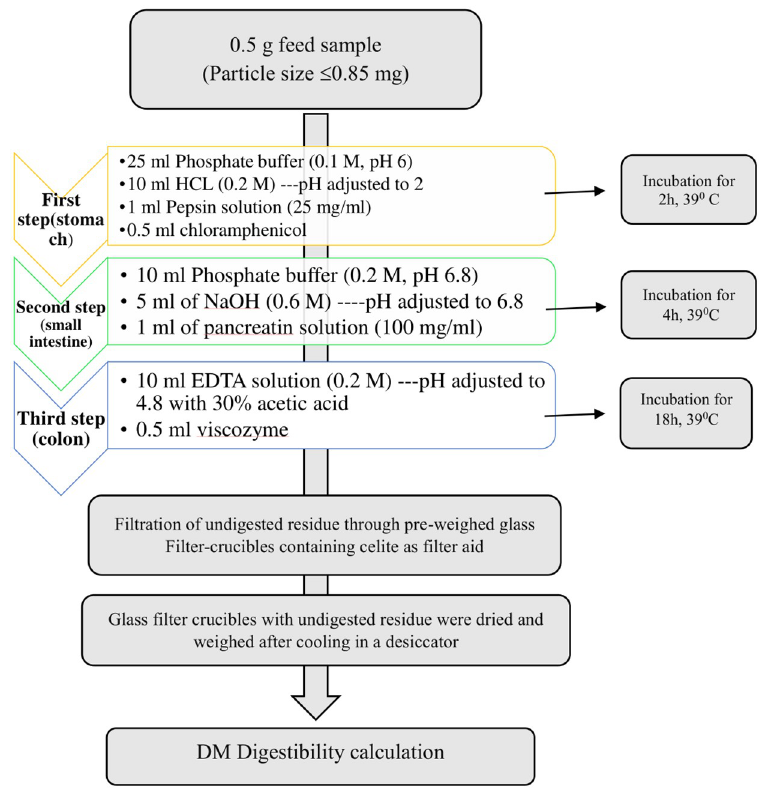
Fig 1. Schematic representation of